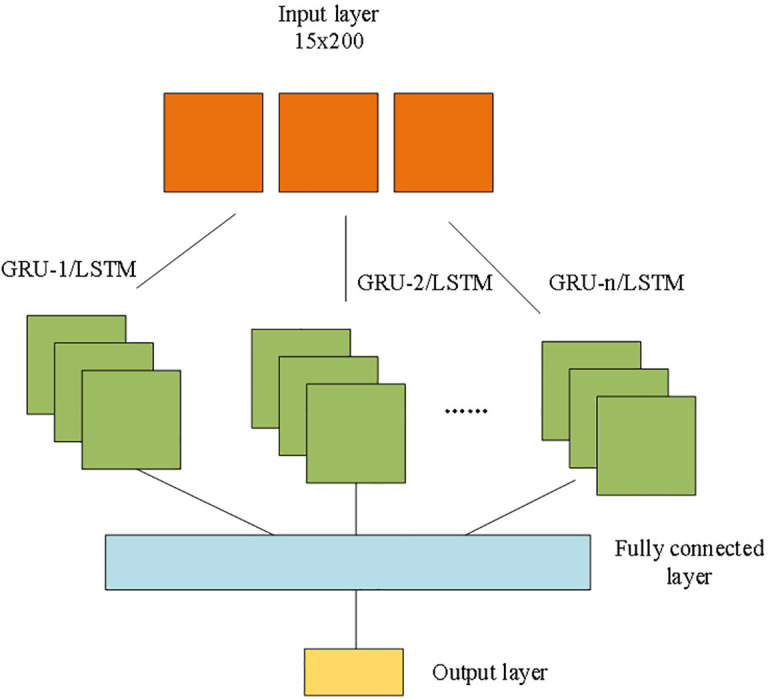
GRU and LSTM translation models.